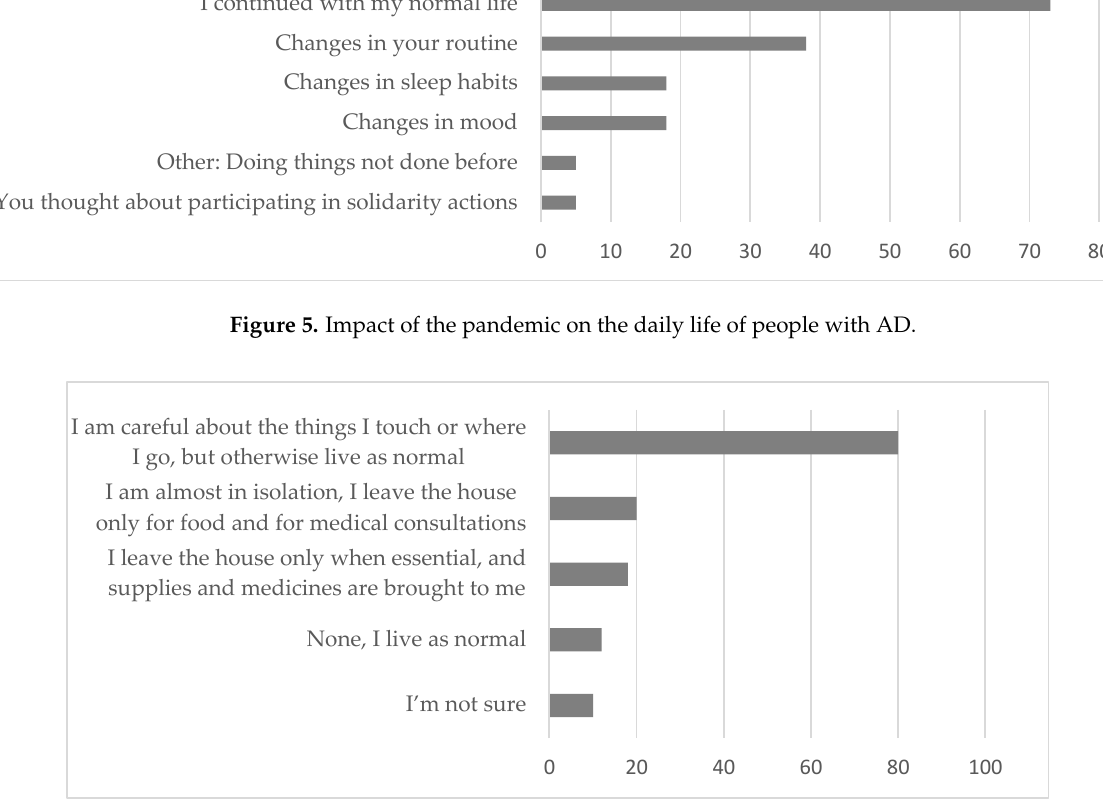
Figure 6. Adoption of measures in a personal capacity to control the pandemic.